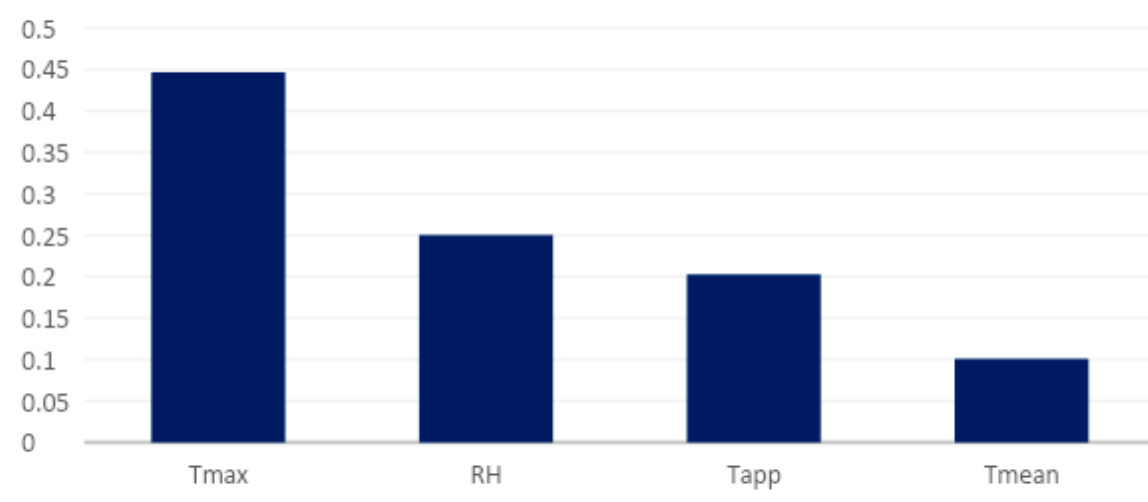
Figure 6. Relative importance of selected features by correlation analysis.